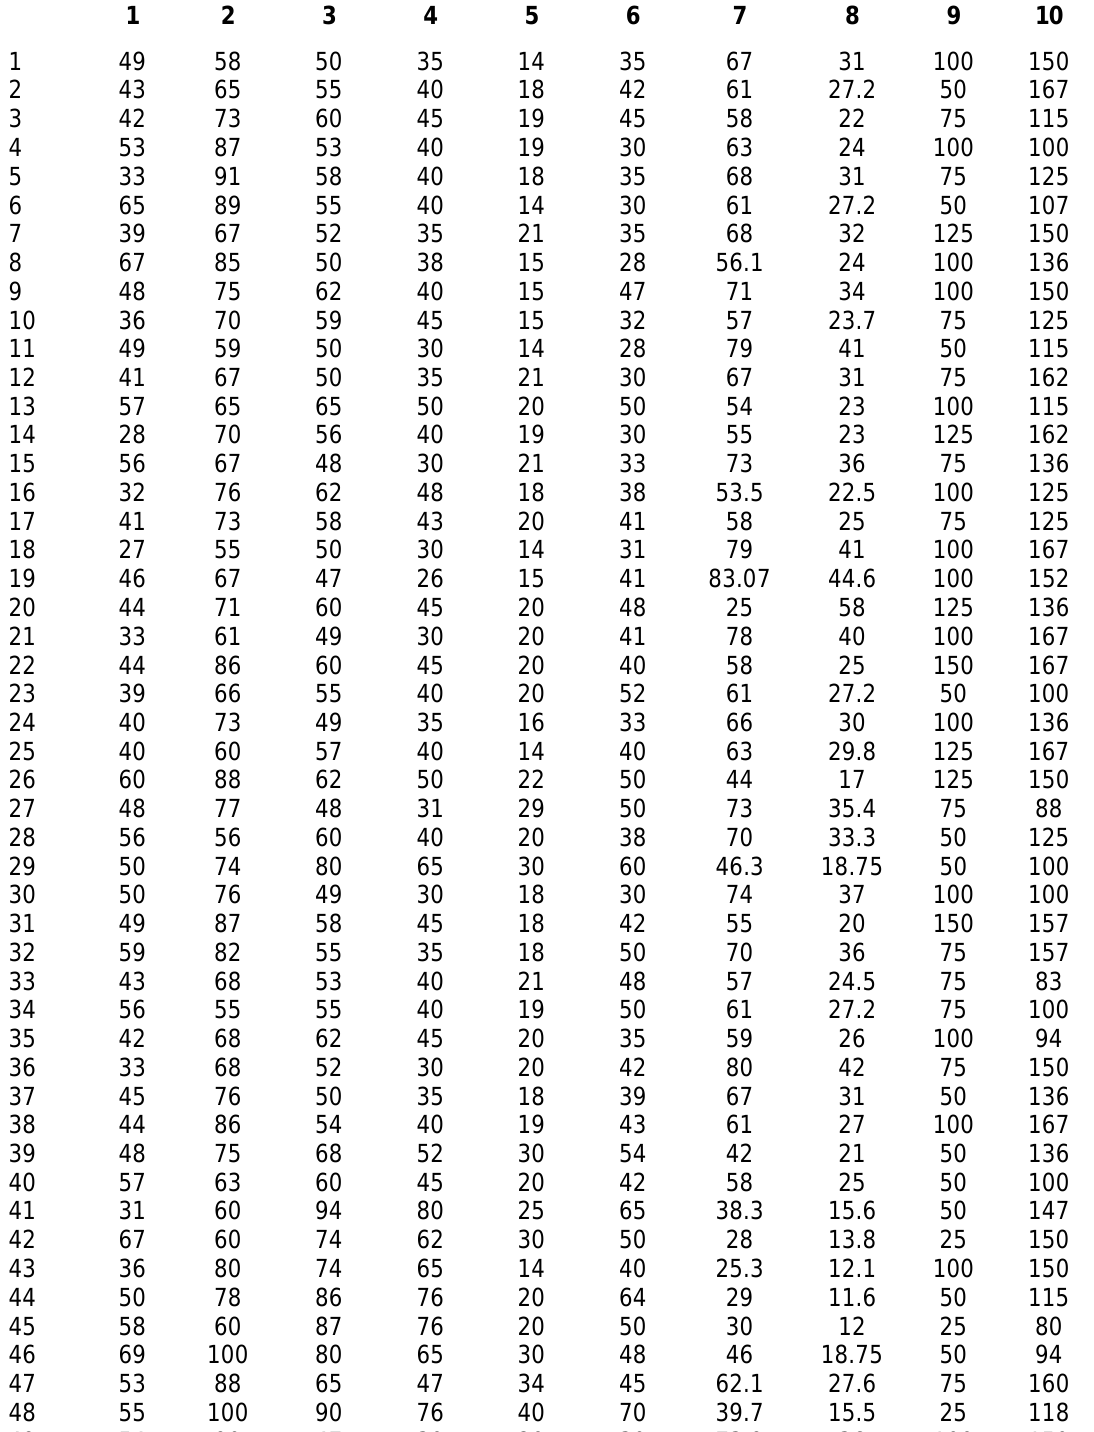
Original Values of the 19 Descriptors for 72 Cardiac Patients (Part